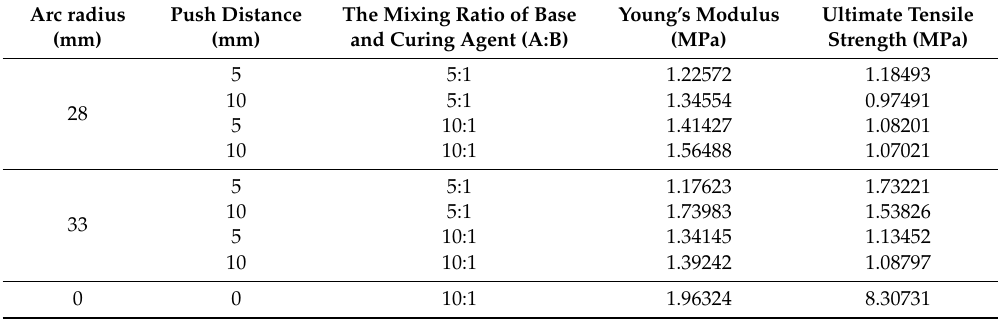
Table 2. Polydimethylsiloxane (PDMS) mechanical properties test results of di ff erent circular arc radiuses.